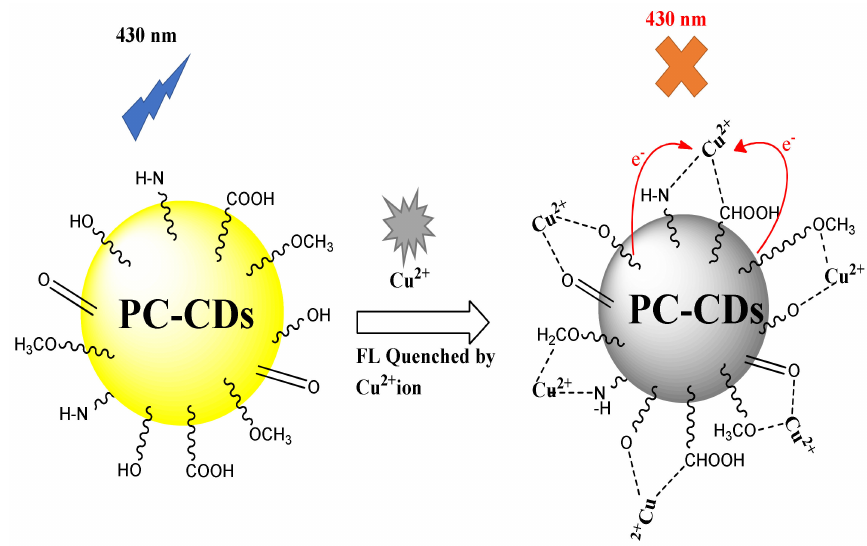
Figure S3. FL intensities synthesized PC-CDs in the presence of interfering metal ions (brown bar) and the mixture solution of Cu 2+ with interfering metal ions (green bar); Table S1. Detection of Cu 2+ in real waste water